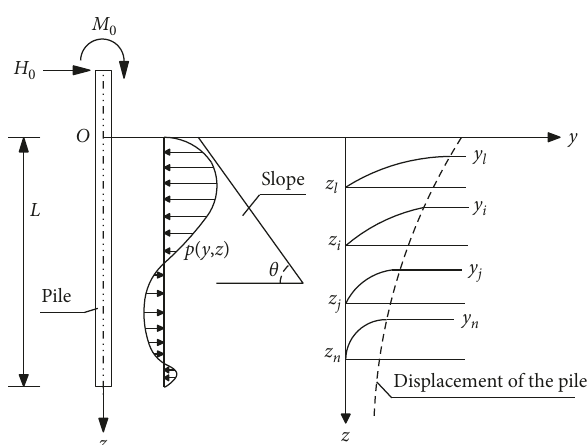
Figure 4: Finite difference method cell division.